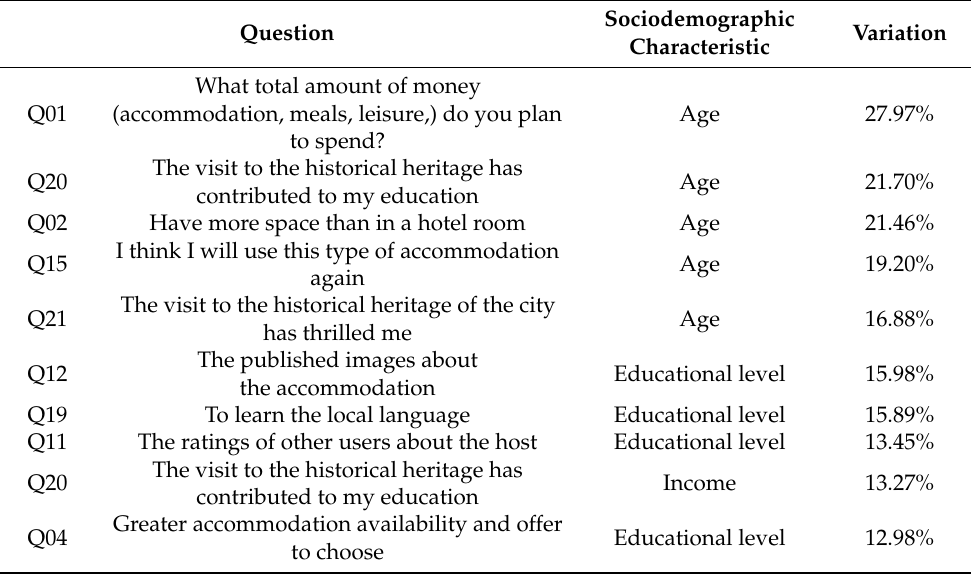
Table 6. Questions with the most direct influence in profiles’ sociodemographic characteristics.